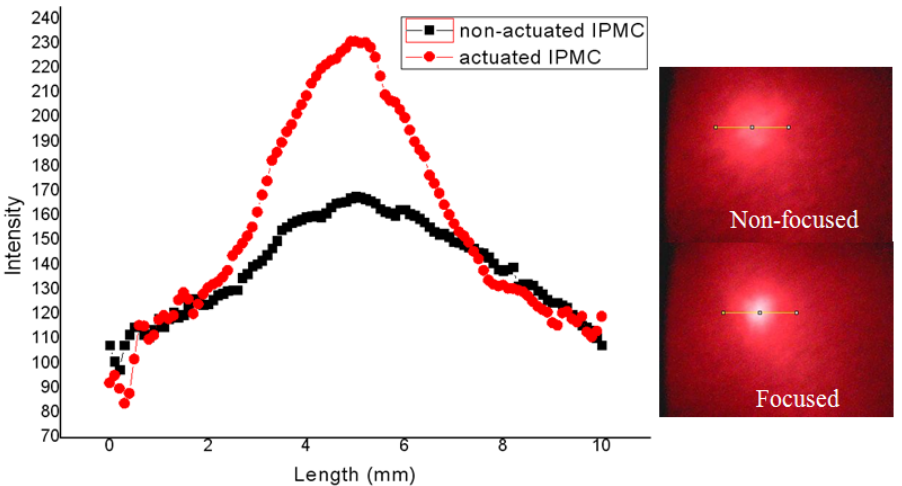
Figure 11. The surface profile of IPMC using an atomic force microscope (AFM). ( a ) the non-improved surface (R = 1.29 µm); ( b ) the improved surface (R rms